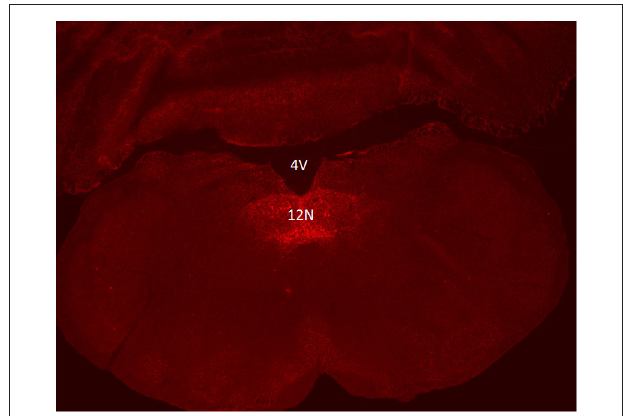
FIGURE 1 | Localization of AAV5-hSyn-hM4 (Gi)-mCherry DREADD in the hypoglossal nucleus. Fluorescent microscopy images ( × 10) show mCherry expression spanning the hypoglossal nucleus. 12N denotes the hypoglossal nucleus; 4V denotes the fourth ventricle.